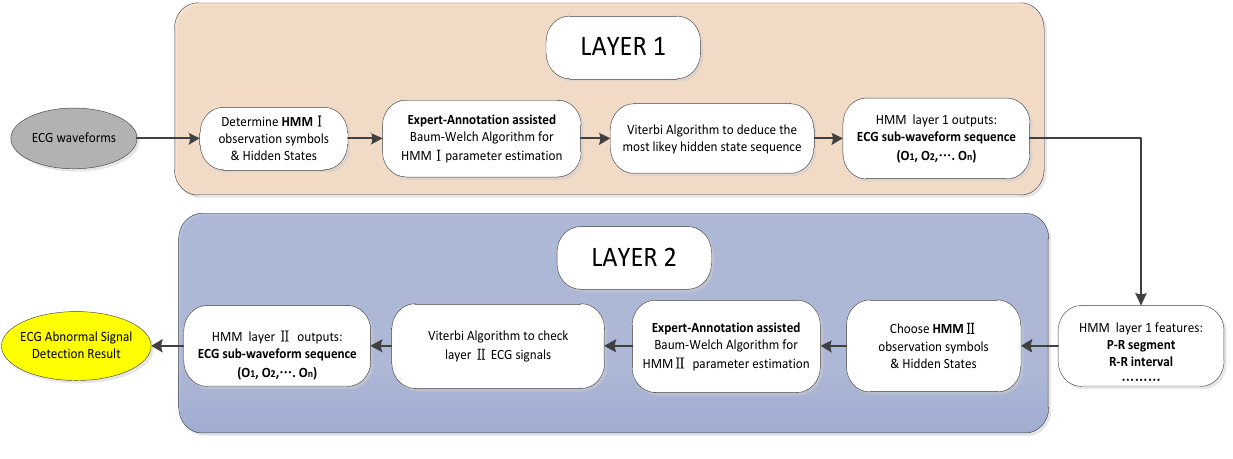
Figure 8. Two-layered Hidden Markov Models for ECG